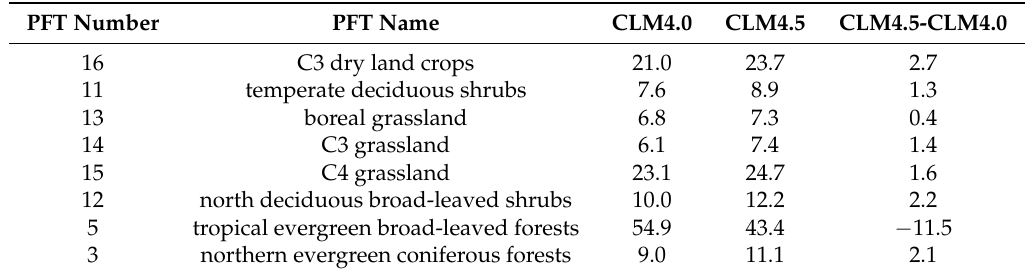
Table 3. Annual mean of the Et (Unit: W/m 2 ) of the dominant PFTs in CLM4.0 and CLM4.5 and their difference (CLM4.5-CLM4.0).